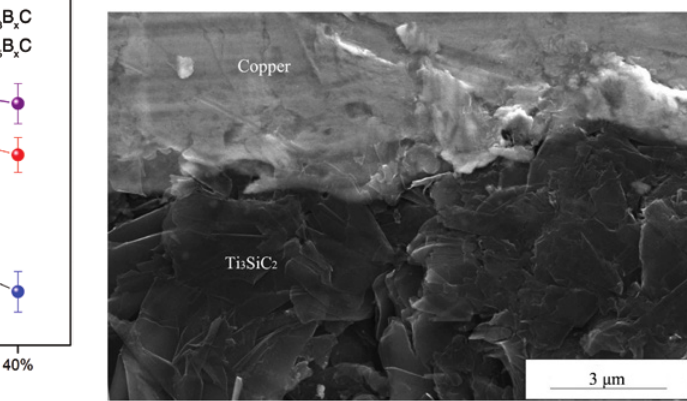
Figure 4: Relative density of Ti